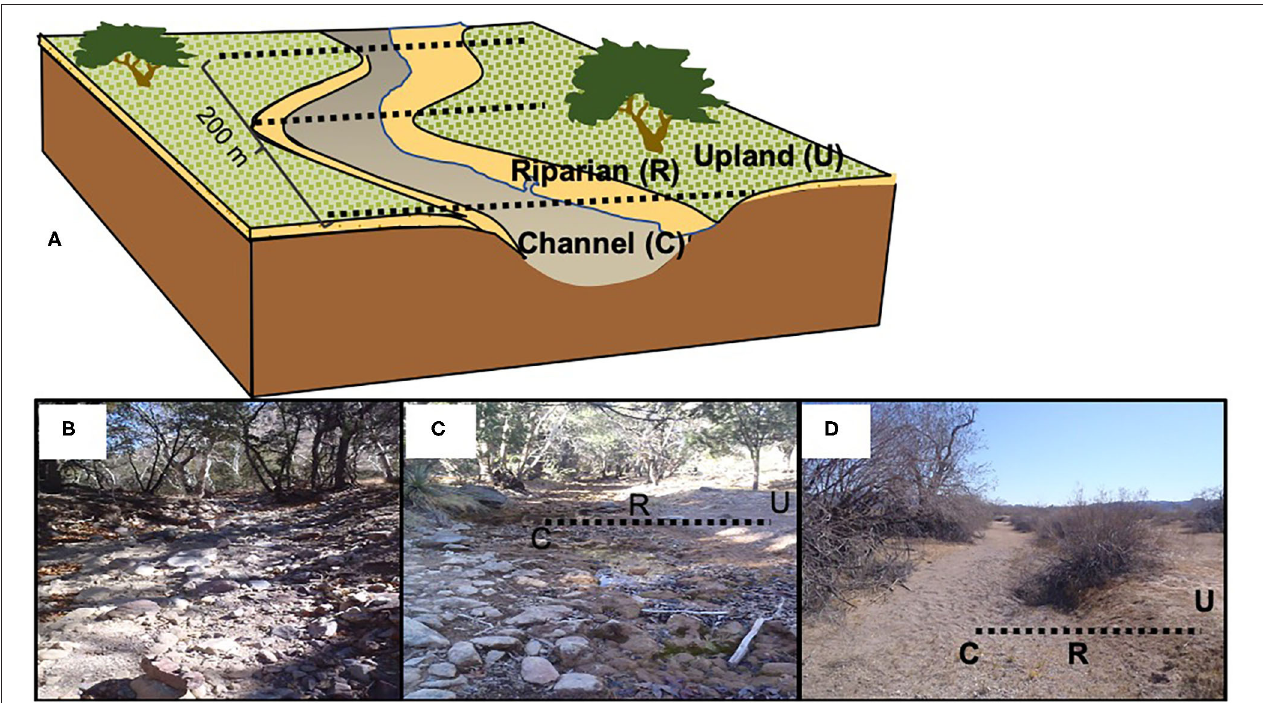
FIGURE 2 | (A) Study site design with location of monitoring stream transects and associated channel, riparian, and upland position. Examples of channel, riparian and upland positions at (B) HU, Huachuca Upper Canyon; (C) GL, Garden Lower; and (D) BG, Barry